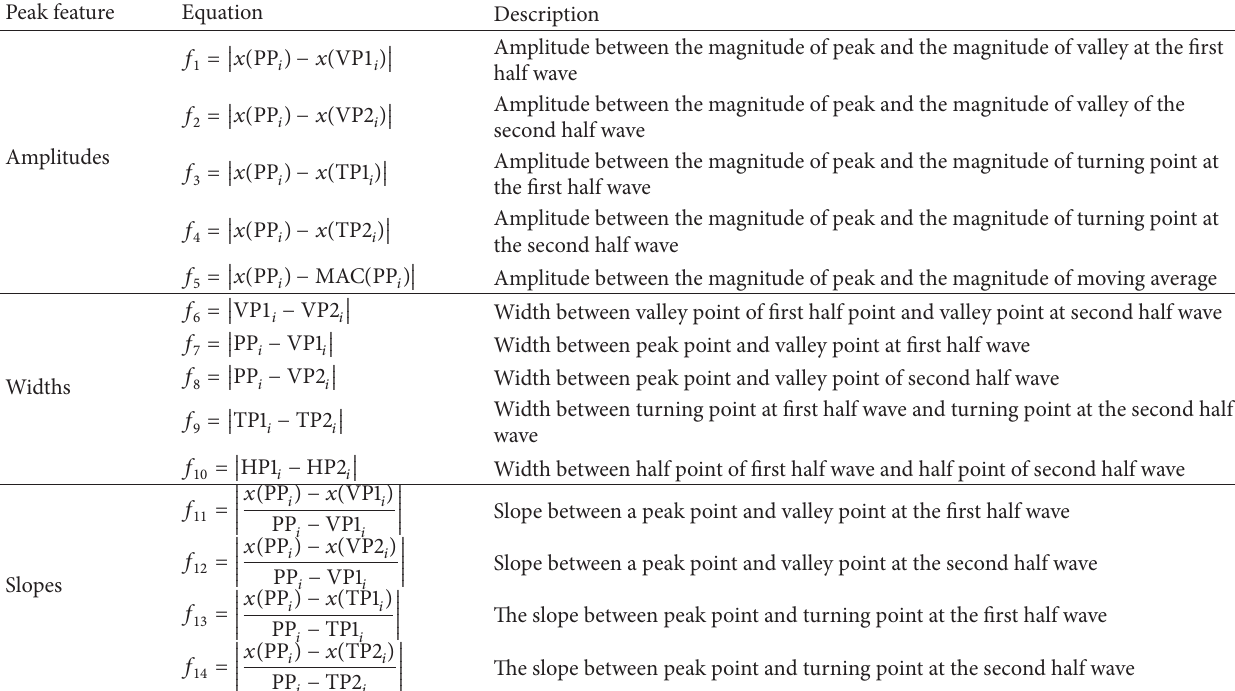
Table 2: Equations and descriptions of peak features.